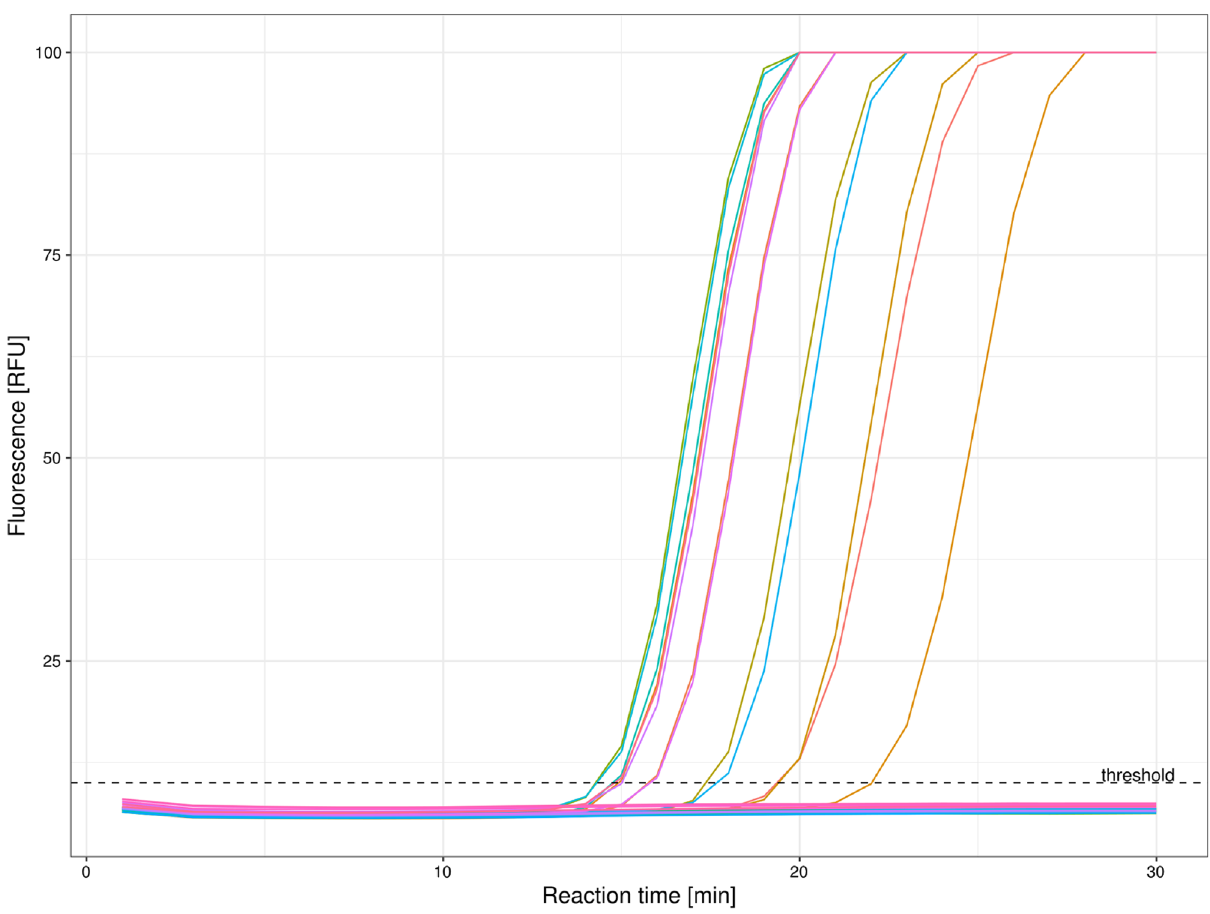
Figure 1. Amplification curves of SARS-CoV-2 RT-LAMP runs using an intercalating fluorescent dye for detection. During the 30 min isothermal incubation (65 °C), the fluorescence signal is read minutely on the FAM channel. A threshold is applied to identify positive samples and calculate the threshold time (Tt)